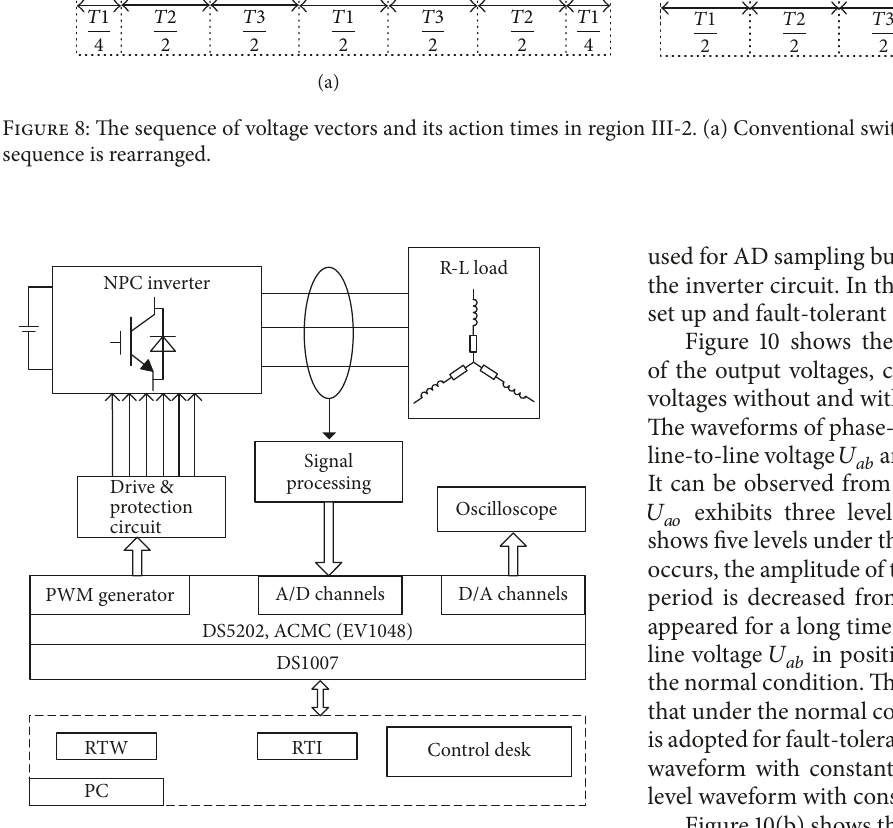
Figure 9: Experimental structure diagram.